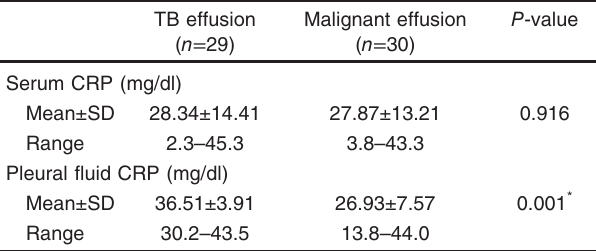
Table 2 Serum and pleural fluid C-reactive protein levels among studied